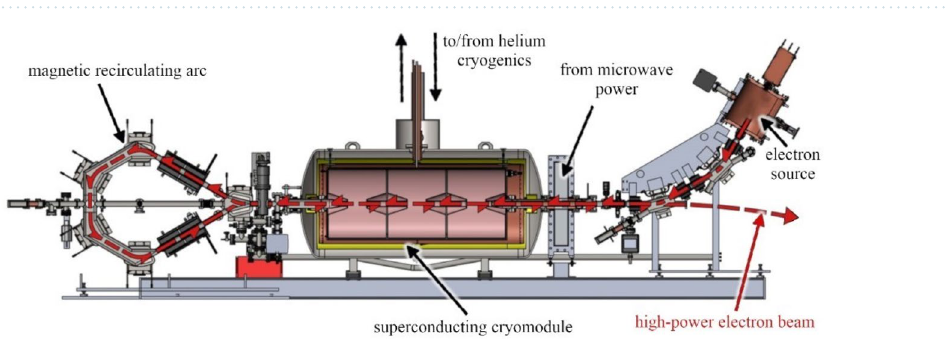
Figure 1. Process overview of the purification steps to produce HSA 99 Mo from irradiated uranium targets.